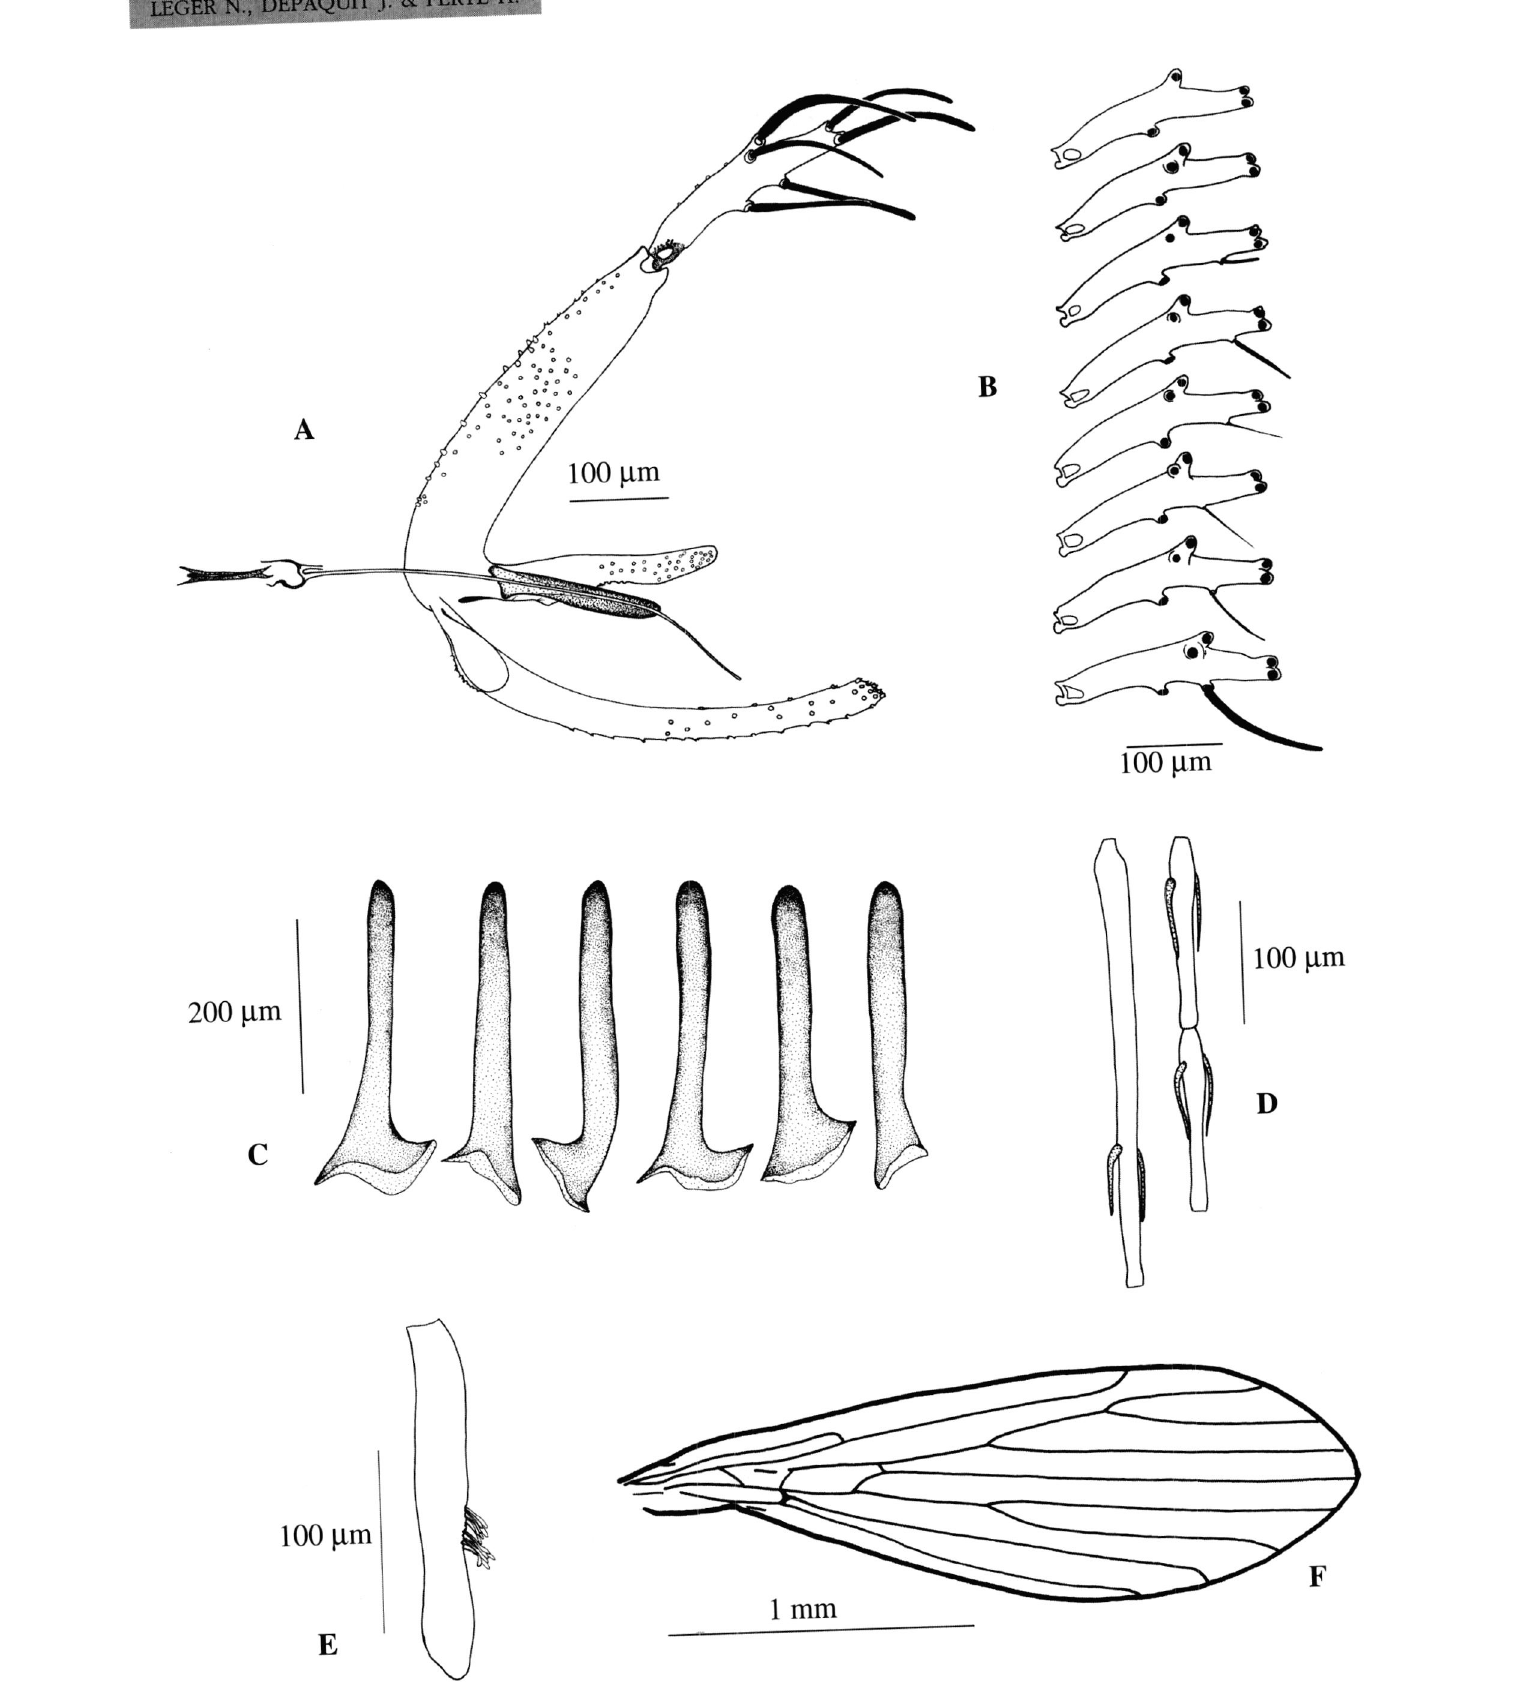
Fig. 4. —P economidesi mâle. A : génitalia ; B : diverses implantations des épines du style ; C : divers aspects de l'édéage ; D : segments antennaires III, IV et V; E : troisième segment palpaire; F :